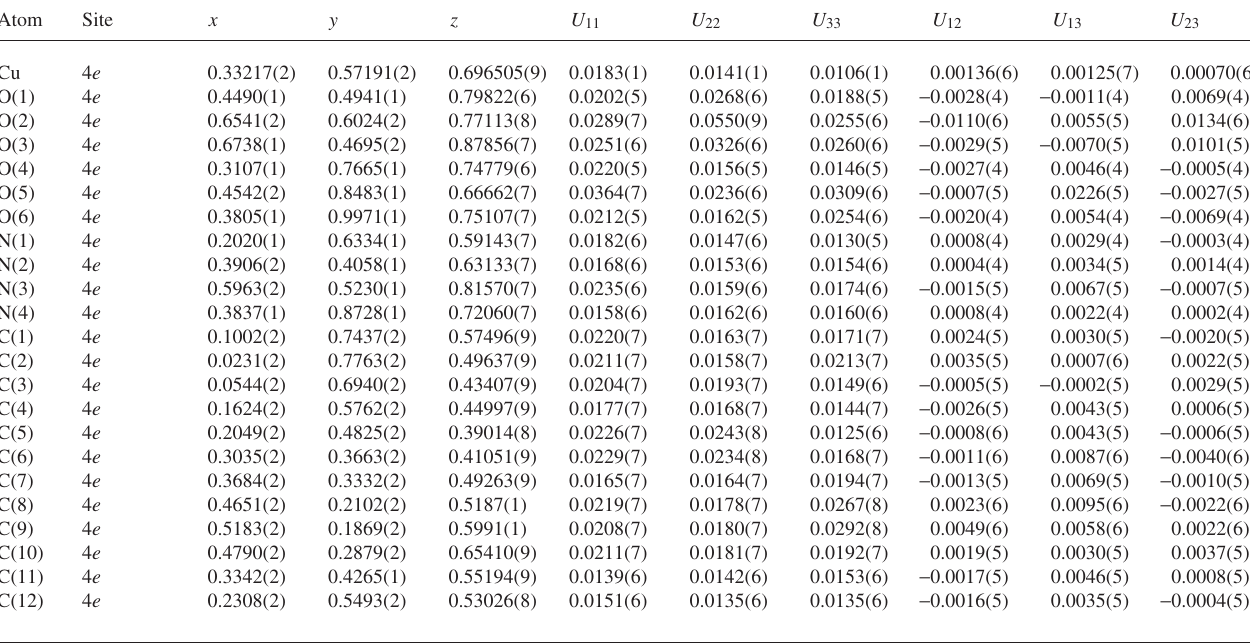
Table 3. Atomic coordinates and displacement parameters (in Å 2 )